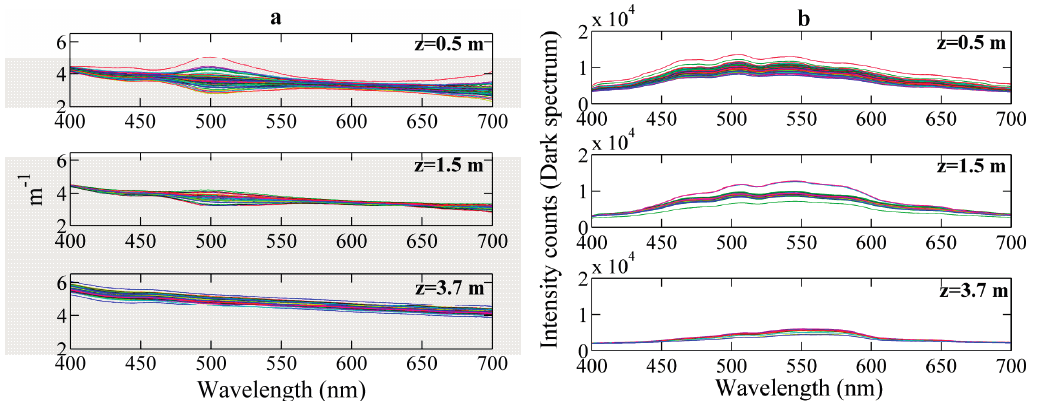
Figure 10. ( a ) Beam attenuation and ( b ) dark spectrum measured for several minutes at different depths in Alfacs Bay (NW Mediterranean coast, Spain) in March